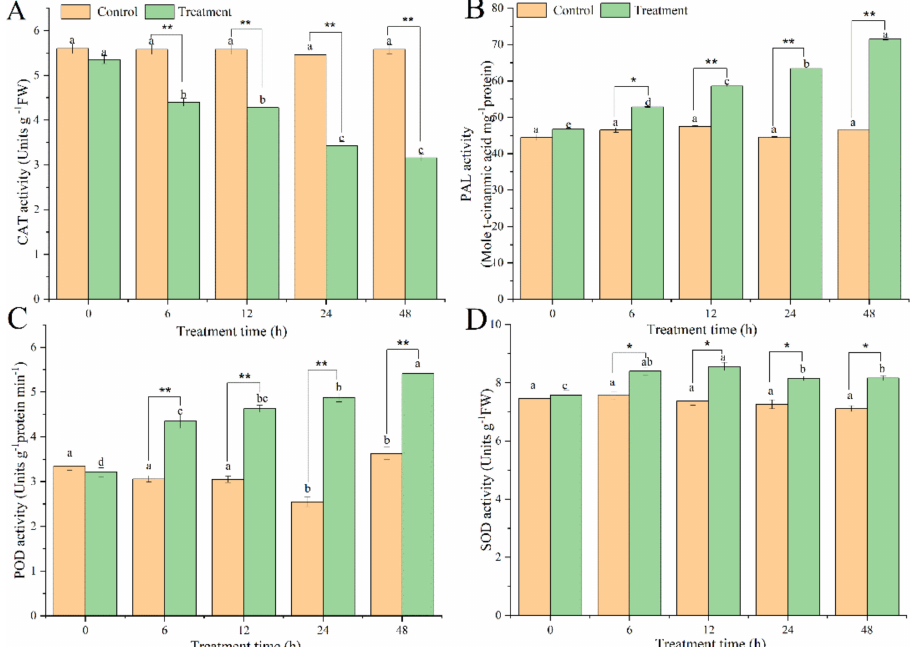
Figure 2. The effect of BY6 on Pdpap poplar oxidase indicators activity. ( A ): Catalase (CAT). ( B ): Phenylalanine ammonia-lyase (PAL). ( C ): Peroxidase (POD). ( D ): Superoxide dismutase (SOD). The experiment was carried out in four biological replicates. The graphical values were the average of four biological repeats. Error bars represent standard errors of the mean ( n = 4) at each time point. Different * indicate significant differences between the groups at the same time point (ANOVA, * < 0.05; ** < 0.01), and the different lowercase letters indicate significant differences for the same treatment group at different times (ANOVA, p < 0.05).